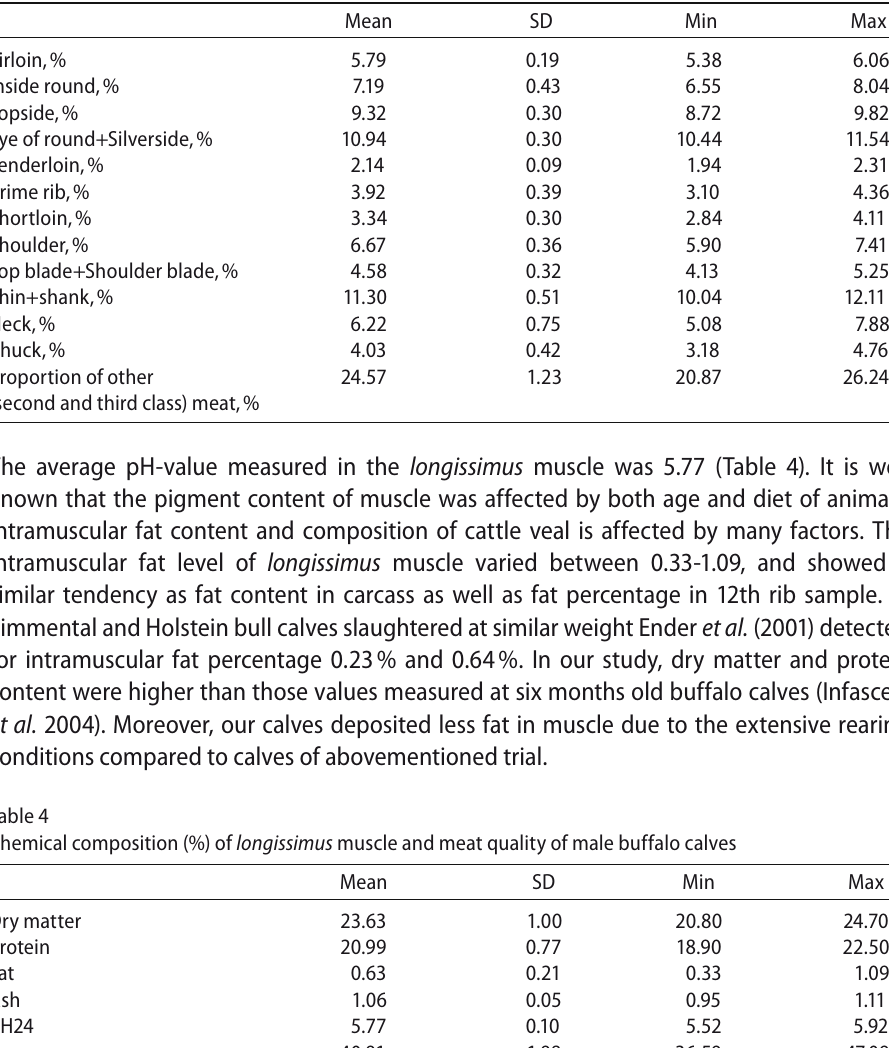
Commercial meat cuts (%) proportion of buffalo male calves